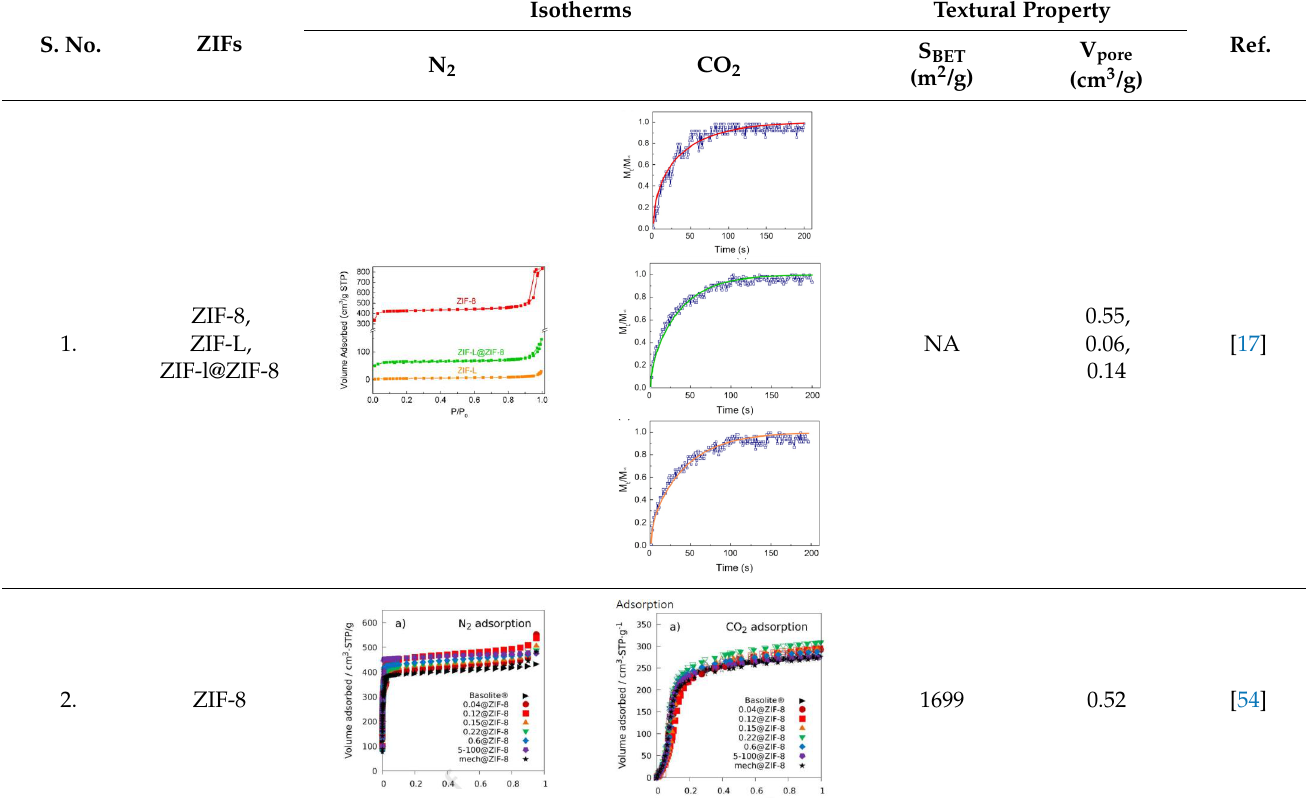
Table 3. ZIFs and their observations after adsorption-desorption isotherms.